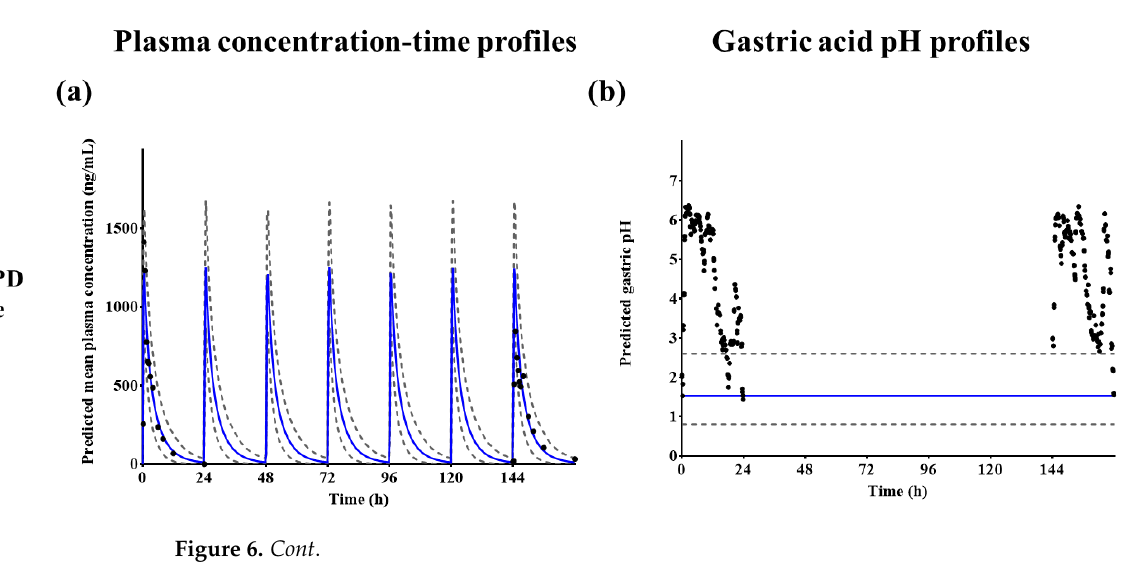
Figure 6. Predicted ( a , c ) plasma tegoprazan concentration and ( b , d ) gastric acid pH – time profiles after repeated administrations of 100 mg tegoprazan once daily for 7 days. Blue solid lines represent the predicted mean values, gray dotted lines represent the predicted 5th and 95th percentile, and black dots represent the observed plasma tegoprazan concentration or gastric acid pH profiles, re- spectively. When evaluating t he percent holding rate at pH ≥ 4 for 24 h, which is a PD parameter, the holding rate after a single administration of 50 mg tegoprazan or repeated administra- tions of 100 mg tegoprazan once daily for 7 days matched the results of the clinical studies (Table 6).